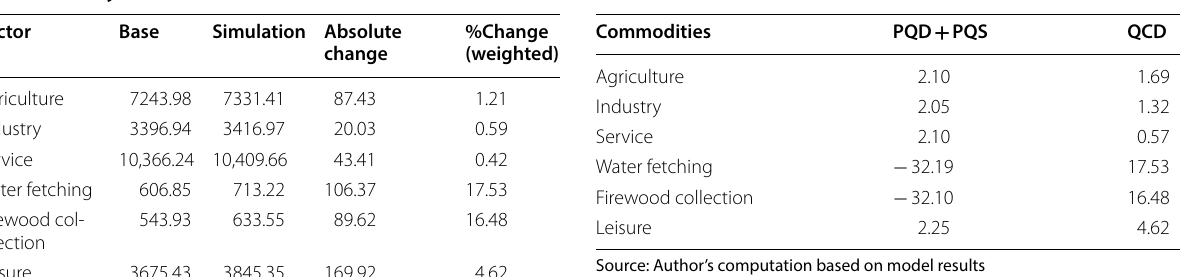
Table 4 Simulated changes (percentage) in domestic